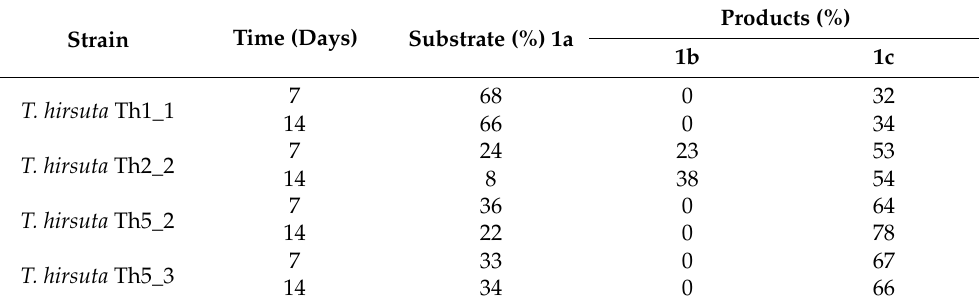
Table 4. Biotransformation of isosafrole ( 1a ) by Trametes hirsuta strains (percentage values according to the